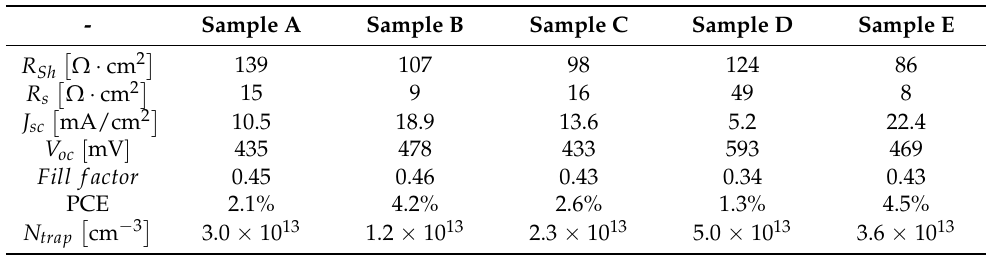
Table 2. Main photovoltaic parameters of solar cells realized with different window layers. The experimental errors are lower than